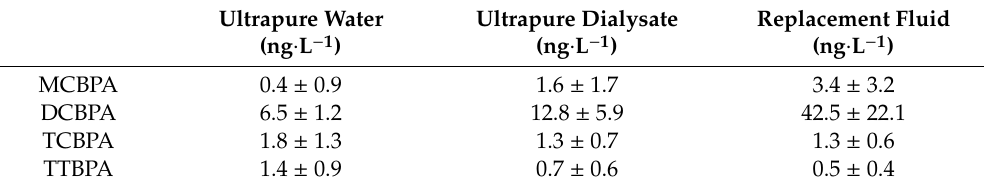
Table 4. Concentration of bisphenol A chlorinated derivatives in ultrapure water and at the beginning of ultrapure dialysate and replacement fluid production. Mean ± standard deviation is